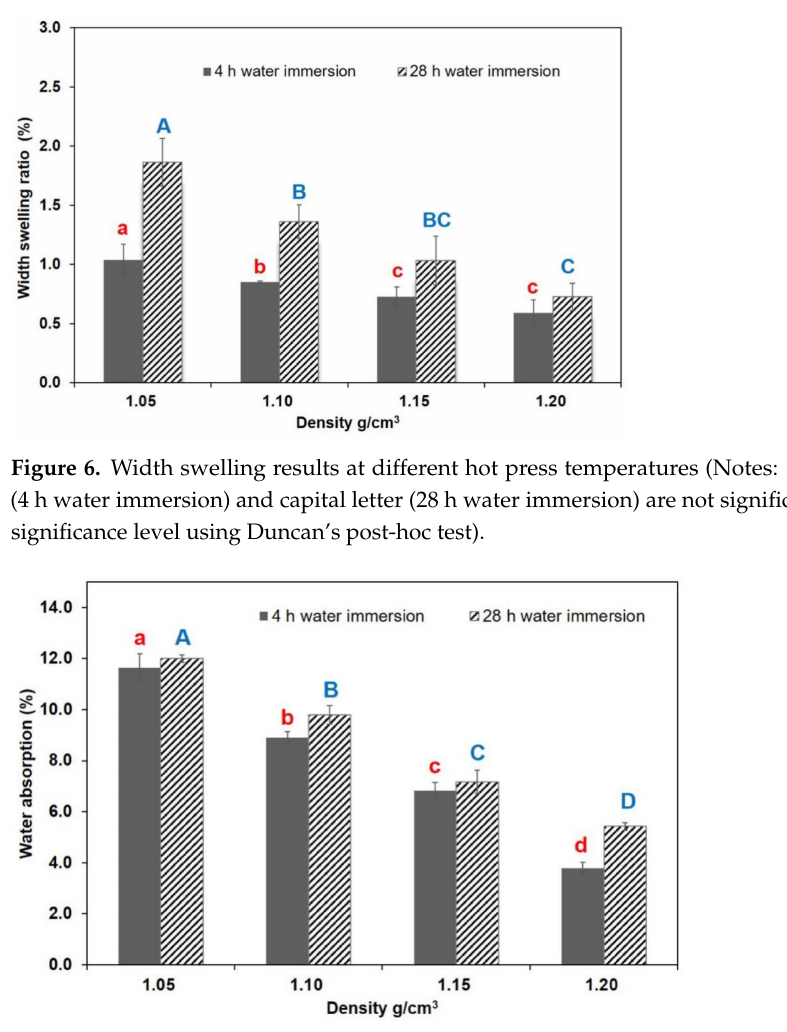
Figure 7. Water absorption results at different hot press temperatures (Notes: The same lowercase (4 h water immersion) and capital letter (28 h water immersion) are not significantly different at 5% significance level using Duncan’s post-hoc